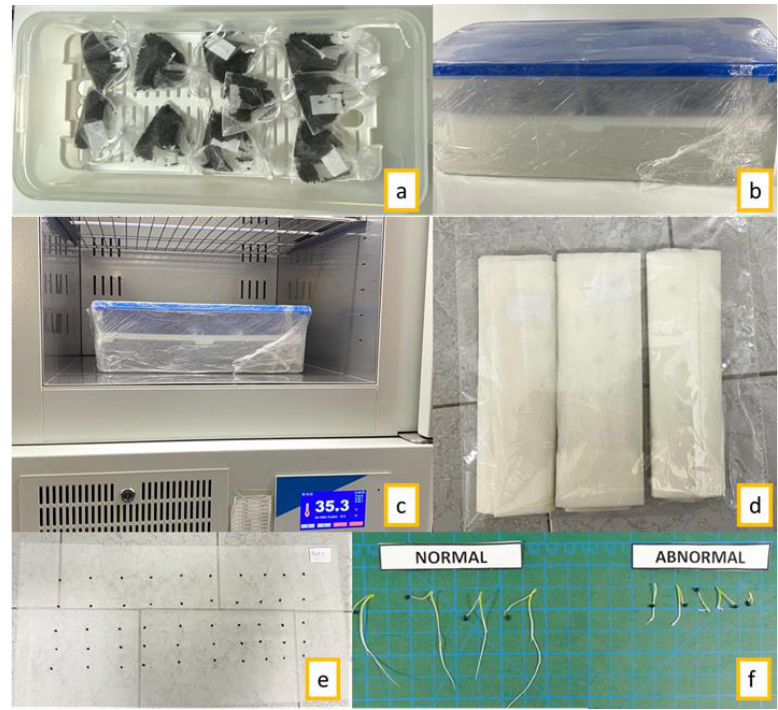
Figure 1. ( a , b ): onion seed lots were put into plastic containers for 75% relative humidity, ( c ) the plastic containers were placed in a germination chamber set at 35 ± 2 °C, ( d , e ) each lot of seeds was rolled in paper towels, ( f ): normal and abnormal onion seedlings.